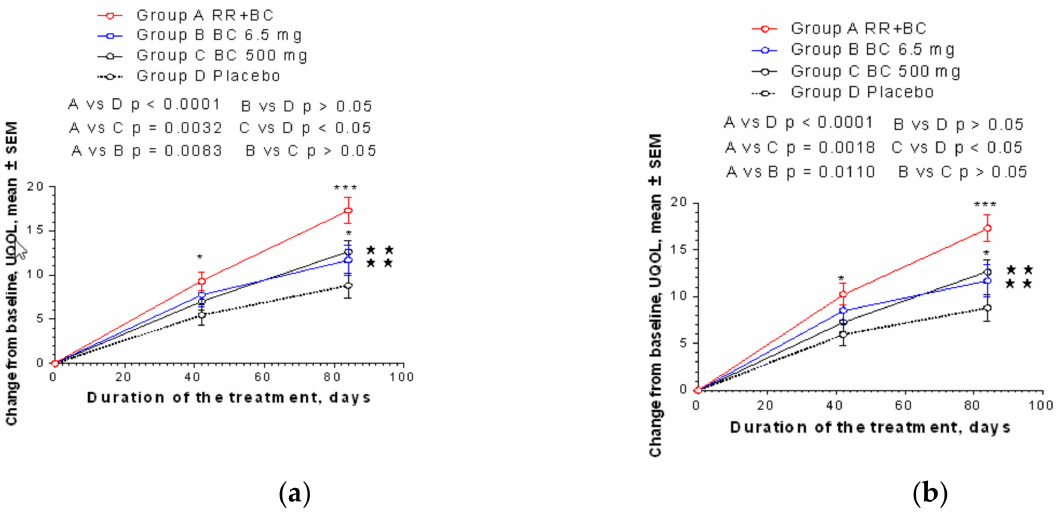
Figure A3. The change from baseline of menopause UQOL scores (mean ± SD) over time: ( a ) -ITT analysis, ( b ) -PP analysis. Significance of di ff erence between groups at various time points, calculated by Bonferroni post-test, is expressed by symbols * p < 0.05, *** p < 0.001; ns: not significant (A, B, C vs. placebo) and ** p < 0.01 (B and C vs. A).